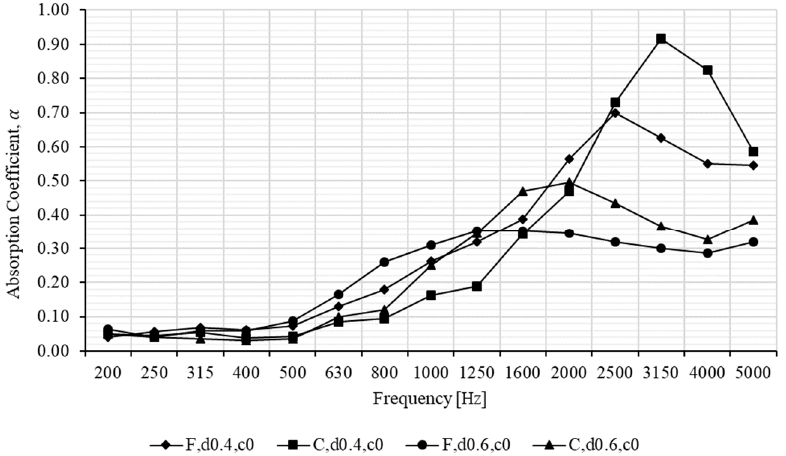
Figure 9. The sound absorption of uncoated particle board bamboos at different particle size and board density.